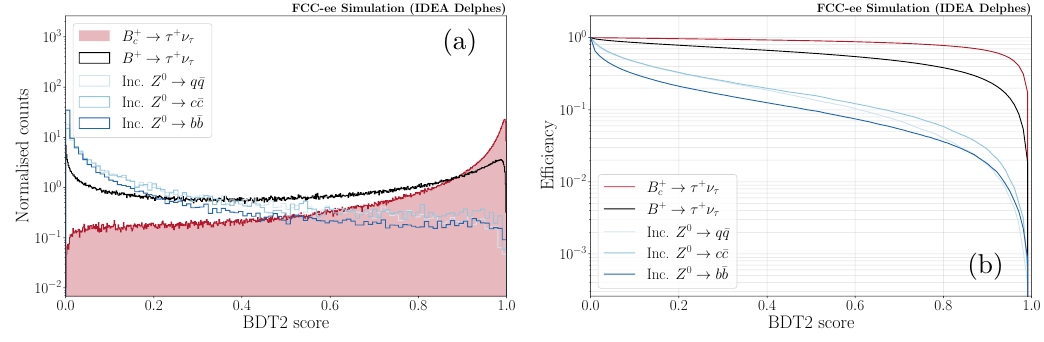
Figure 3 . (Left) Second-stage BDT distribution in signal, B + → τ + ν τ background, and inclusive Z background. (Right) Efficiency of the second-stage BDT as a function of cut